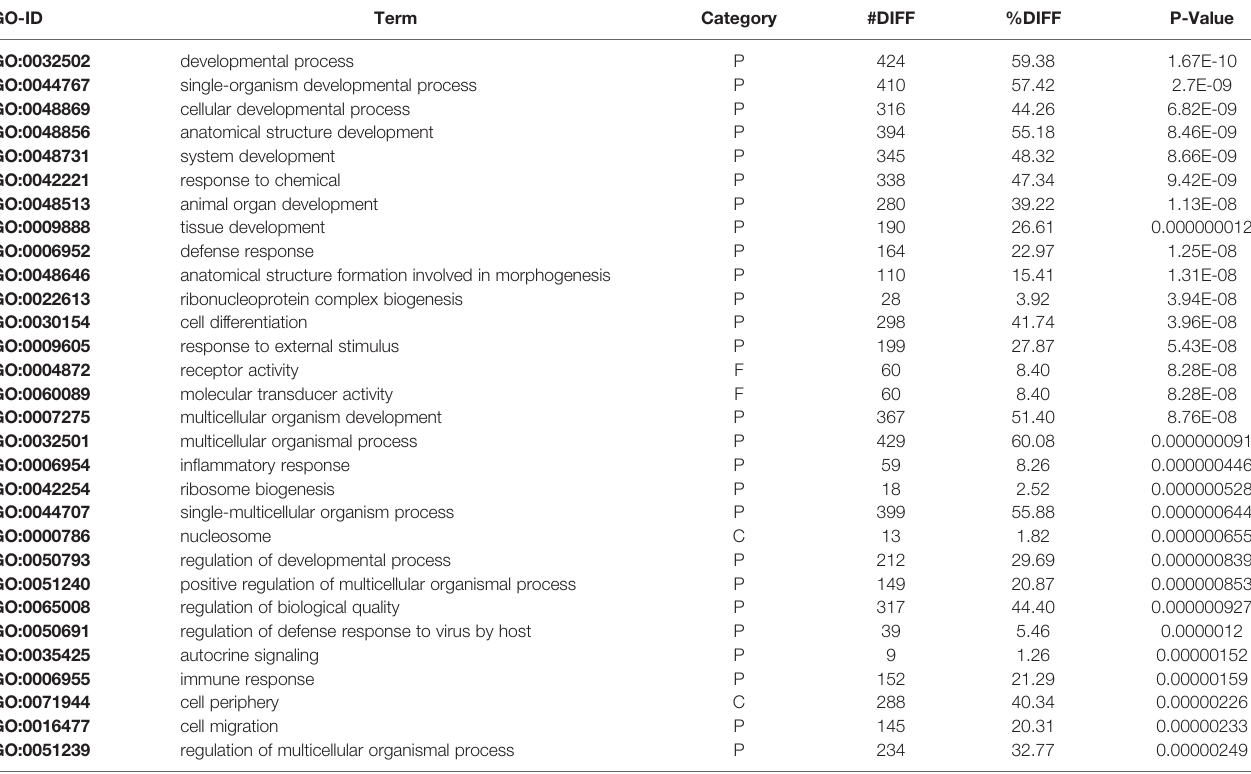
TABLE 2 | Top 30 enriched GO terms among the differentially expressed